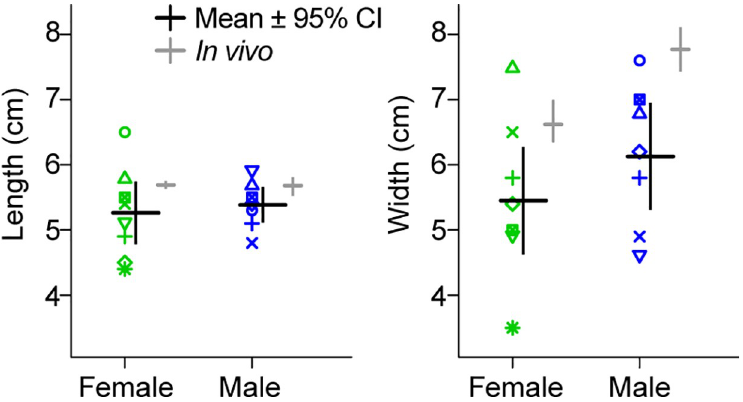
Fig 2. Length and width of the whole crest samples as compared to live peafowl crests. Crests (n = 8 female, n = 7 male) measured in vivo (means shown to the right of each data column) had similar morphology to the dried samples, except that the crests on live birds tended to be wider. Dried sample dimensions were measured to the nearest 0.1 cm. Each crest sample is indicated by a unique symbol-color combination consistent with other figures (see S4 Table for